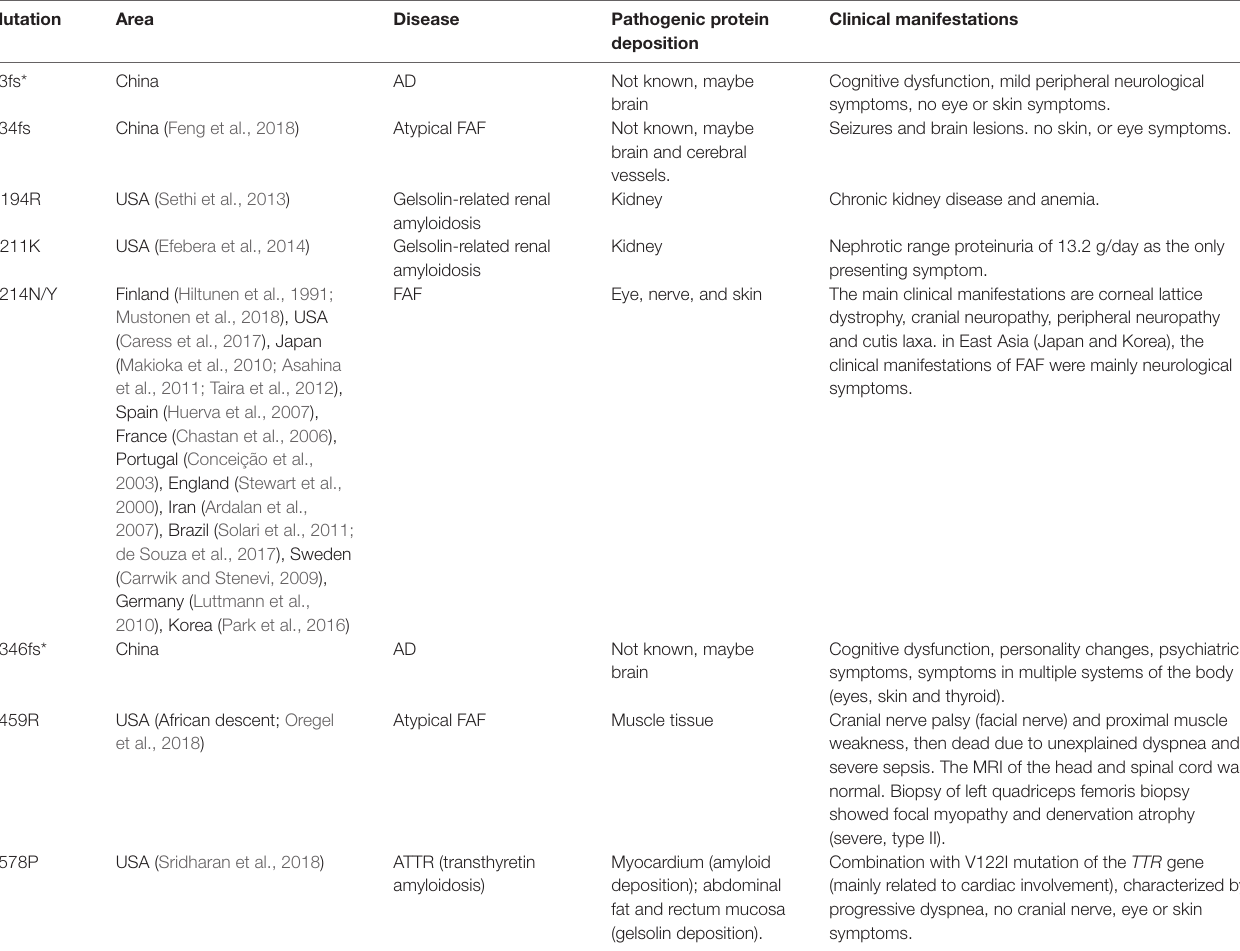
TABLE 4 | Pathogenic mutations in the GSN gene in